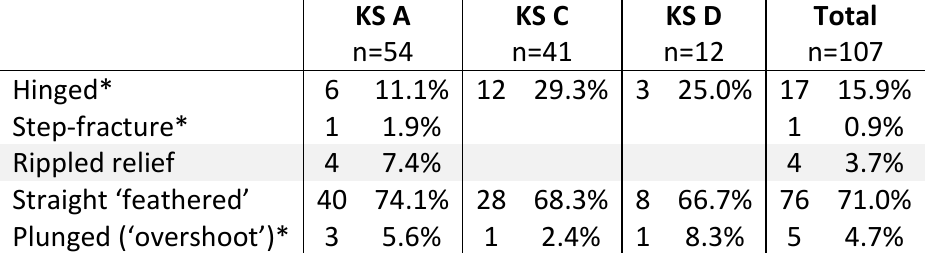
Table 6. Morphology of flake terminations. Abbreviations: * Presumed knapping